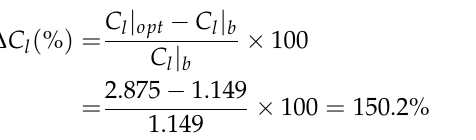
FFD Design Variables with Mobility Frozen Design Variables - Wing Box